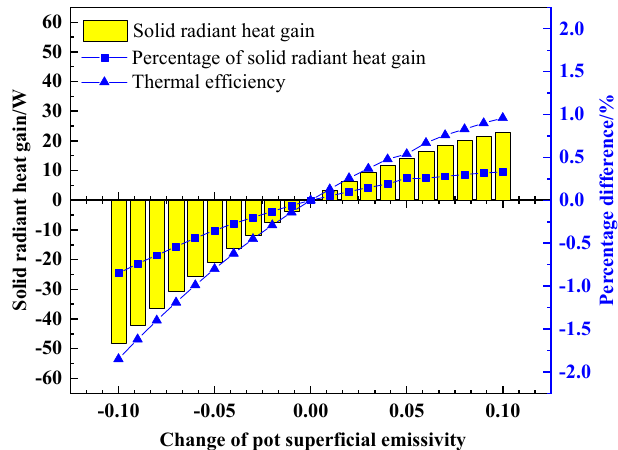
Figure 8. Effective radiant heat gain changing with pot emissivity variation.